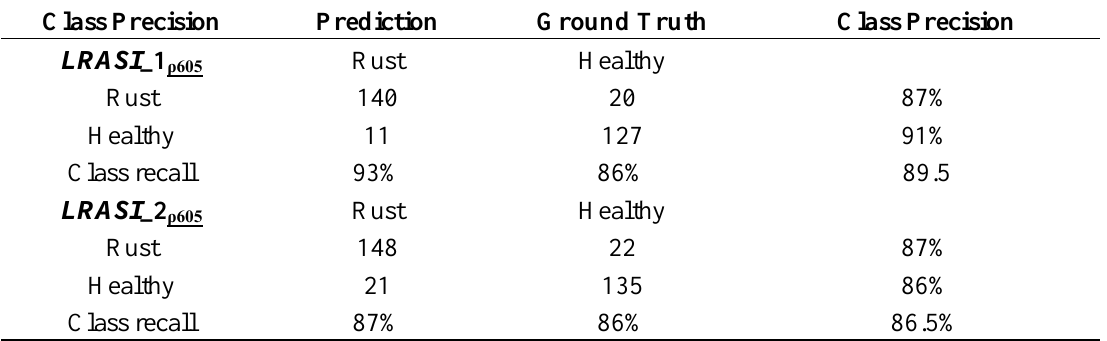
Table 2. Classification accuracy for the healthy and infected classes using leaf rust disease severity indices.